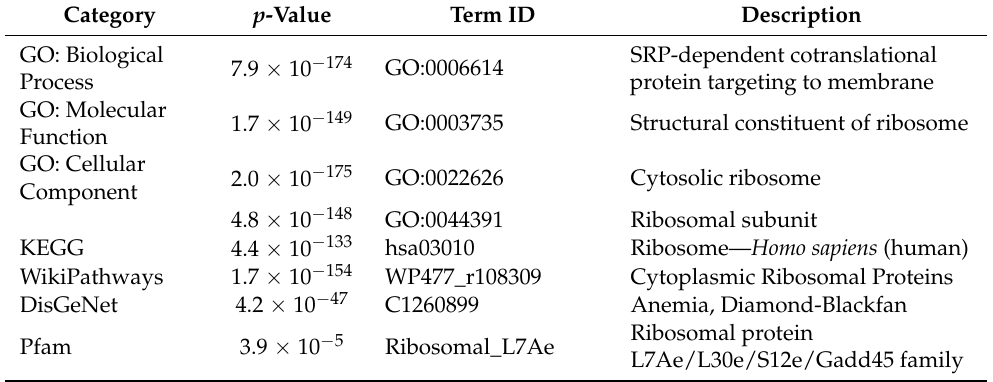
Table 1. Selected top gene term enrichments of the coexpressed genes to RPL11 in